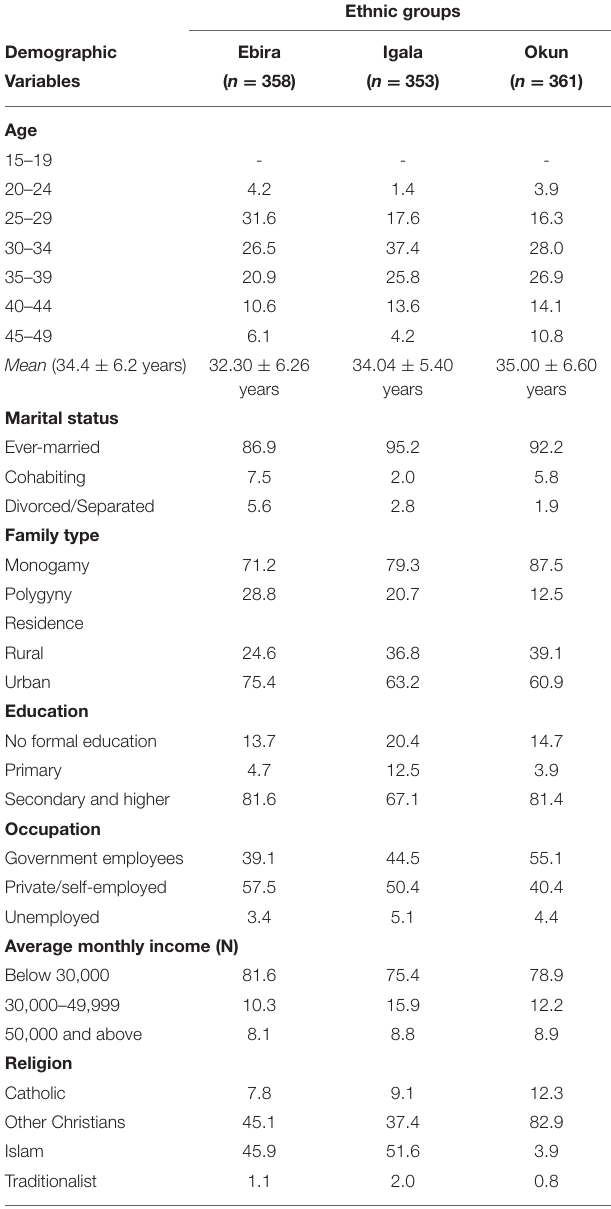
TABLE 1 | Socio-demographic characteristics of the